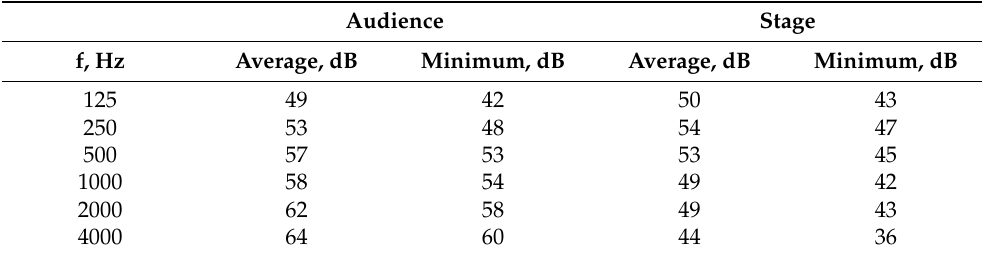
Table 3. Average and minimum INR values.